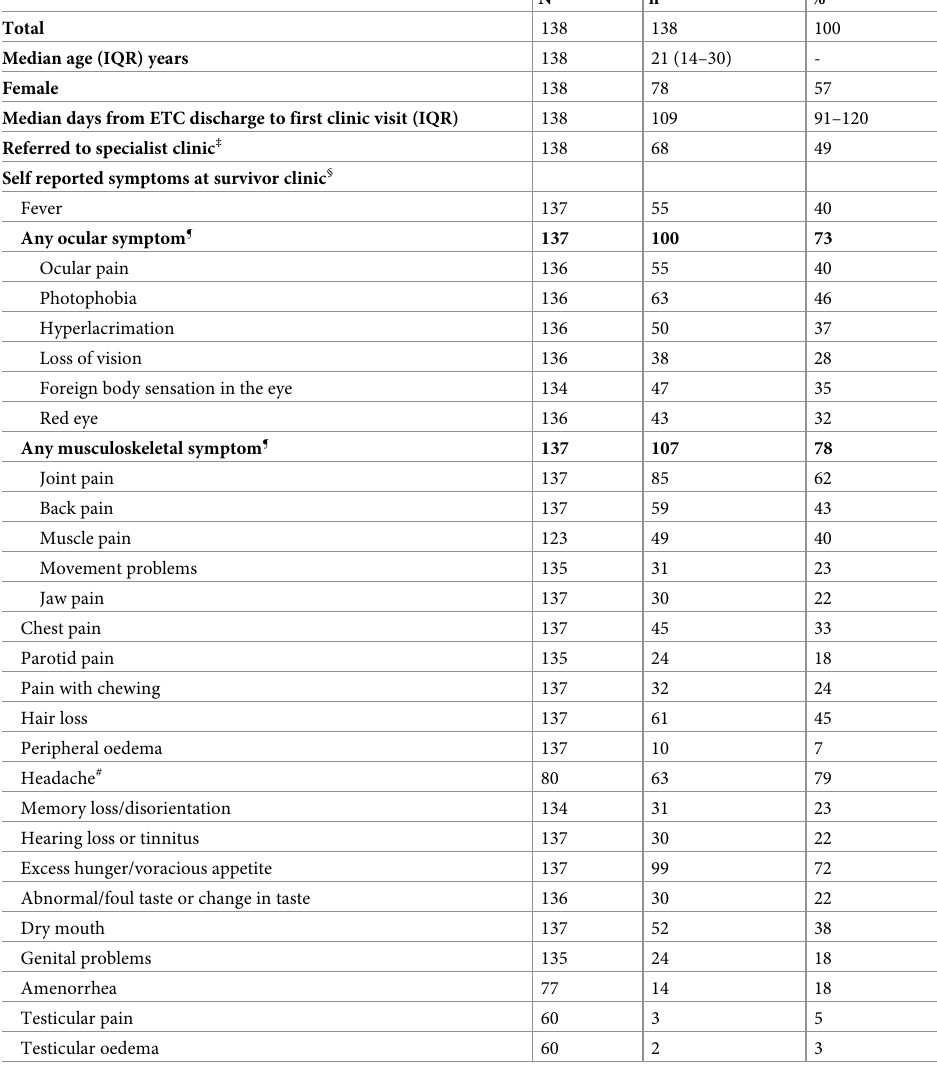
Table 2. Demographic information and self-reported symptoms in 138 attendees of the Kerry Town Ebola survi- vors